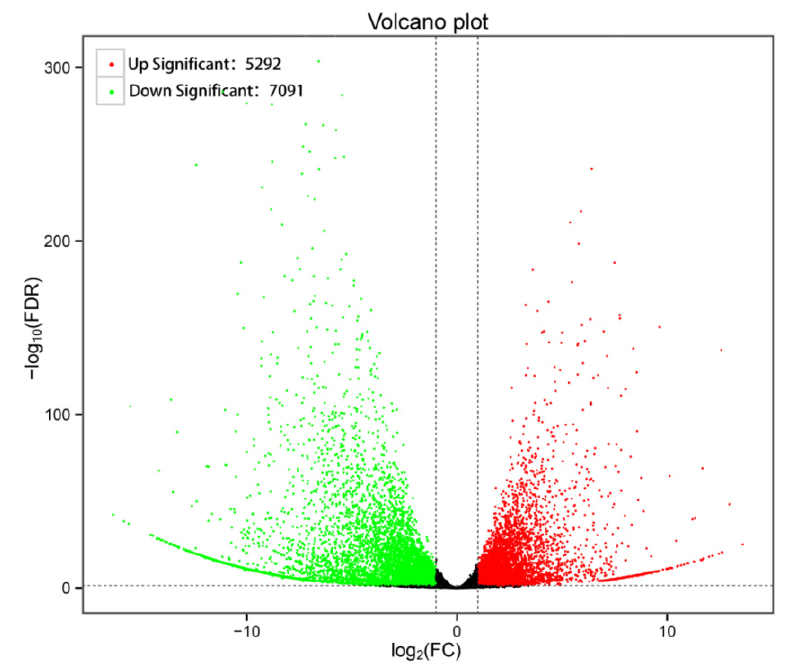
Figure 4. Volcano map of DEGs. The abscissa is the change in gene expression (log 2 FC), and the ordinate is the significance level of differentially expressed genes ( − log 10 FDR). The expression of green genes was down-regulated, the expression of red genes was up-regulated, and the expression of black genes was not significantly different.